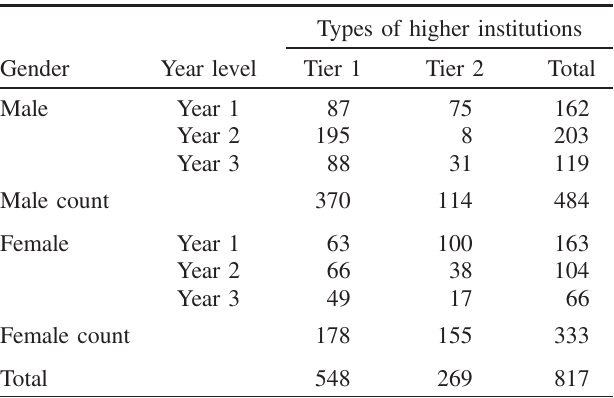
TABLE I. A breakdown of participants in terms of gender, year level, and university tier.